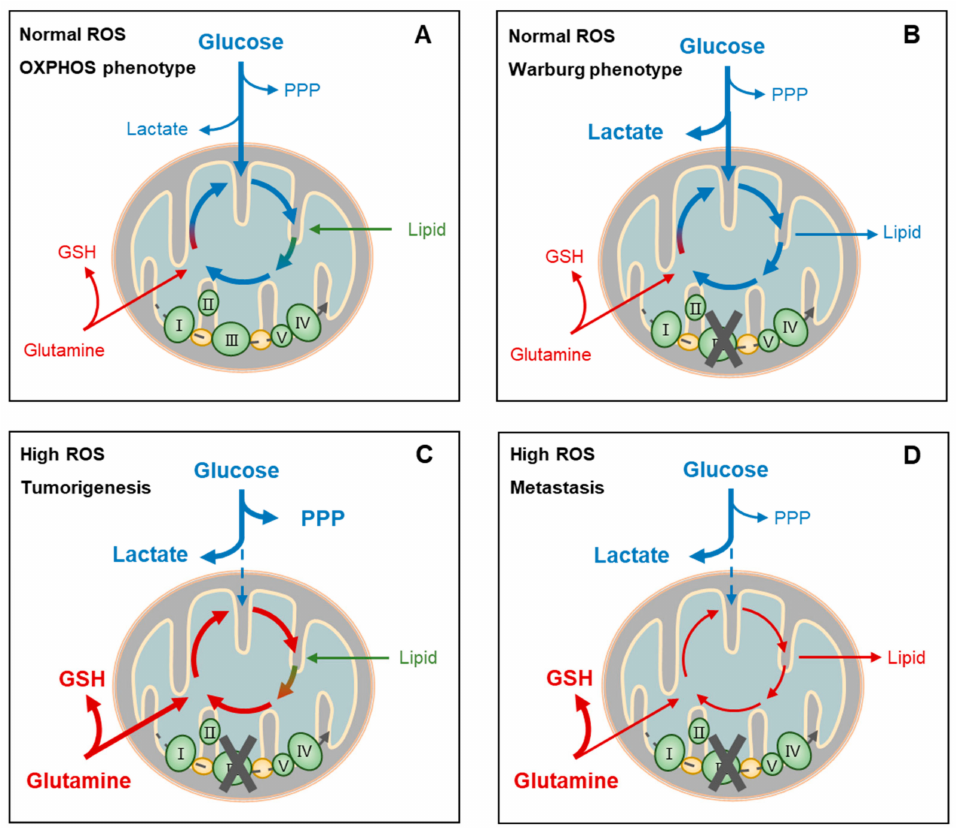
Figure 4. Metabolic adaptation-linked cancer stemness and progression. Cancer cells may present distinct metabolic phenotypes (oxidative phosphorylation, OXPHOS, or Warburg) or biofunctions (tumorigenesis or metastasis) at certain reactive oxygen species (ROS) levels, depending on the circumstances and intrinsic responses. For example, at normal ROS levels, cancer cells of the OXPHOS phenotype depend on aerobic glycolysis, glutaminolysis, and lipolysis for fueling tricarboxylic acid cycle (TCA)-coupled OXPHOS. This highly efficient usage of nutrients for ATP generation facilitates the survival, rather than the proliferation, of cancer cells when facing a shortage of these nutrients ( A ). On the other hand, cancer cells of the Warburg phenotype at normal ROS levels also depend on glycolysis primarily for supporting lactate production and TCA-coupled biosynthesis, rather than OXPHOS, such as the de novo synthesis of amino acids and fatty acids, which is known to facilitate proliferation of cancer cells ( B ). Cancer cells during metastasis and tumor initiation share similarly high ROS conditions and metabolic phenotypes. Extensive ROS blocks aerobic glycolysis, resulting in lactate accumulation ( C , D ) and perhaps pentose phosphate pathway (PPP) activation when proliferation is required in tumorigenesis ( C ). On the other hand, glutamine uptake and glutathione (GSH) generation are upregulated ( C , D ). In addition, TCA function is recovered by glutaminolysis and lipolysis when proliferation requires reactivation for tumorigenesis ( C ). PPP, pentose phosphate pathway; GSH,